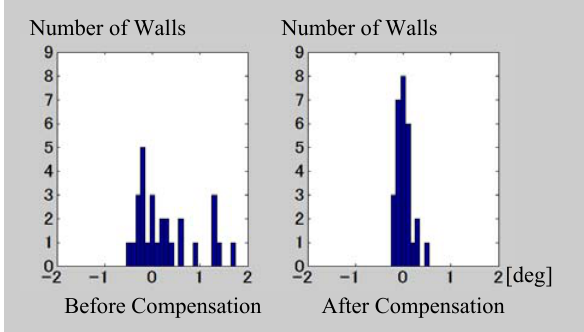
right wall surface position can be extracted by applying a curved surface form. Next, the results of the wall matching compensation processing on the right wall’s direction angle for six buildings (each with four planes) is shown in Figure 10.